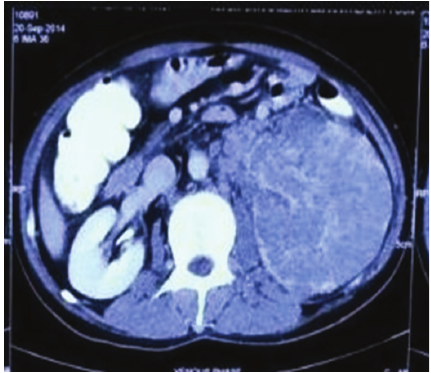
Figure 1: CT image shows enlarged left kidney and it is almost completely replaced with heterogeneously hypodense material.